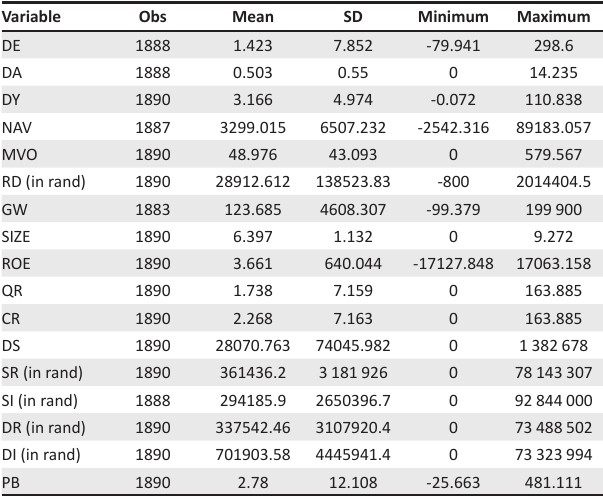
TABLE 2: Descriptive statistics without